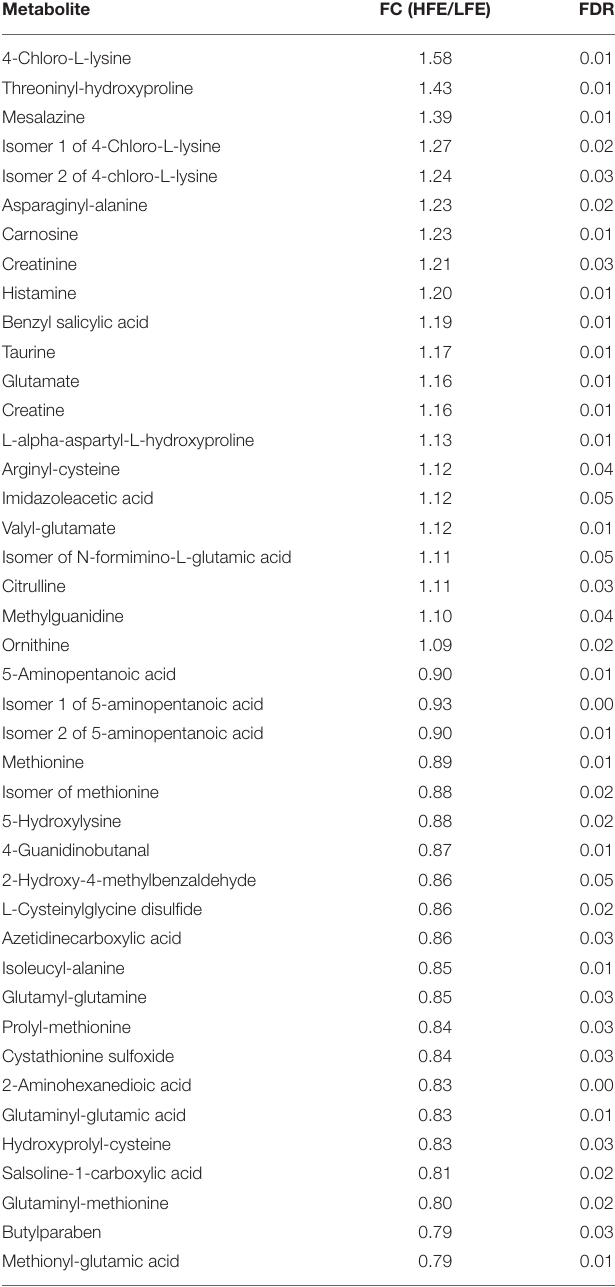
TABLE 2 | Differentially abundant amine/phenol-metabolites in beef steers with divergent residual feed intake.